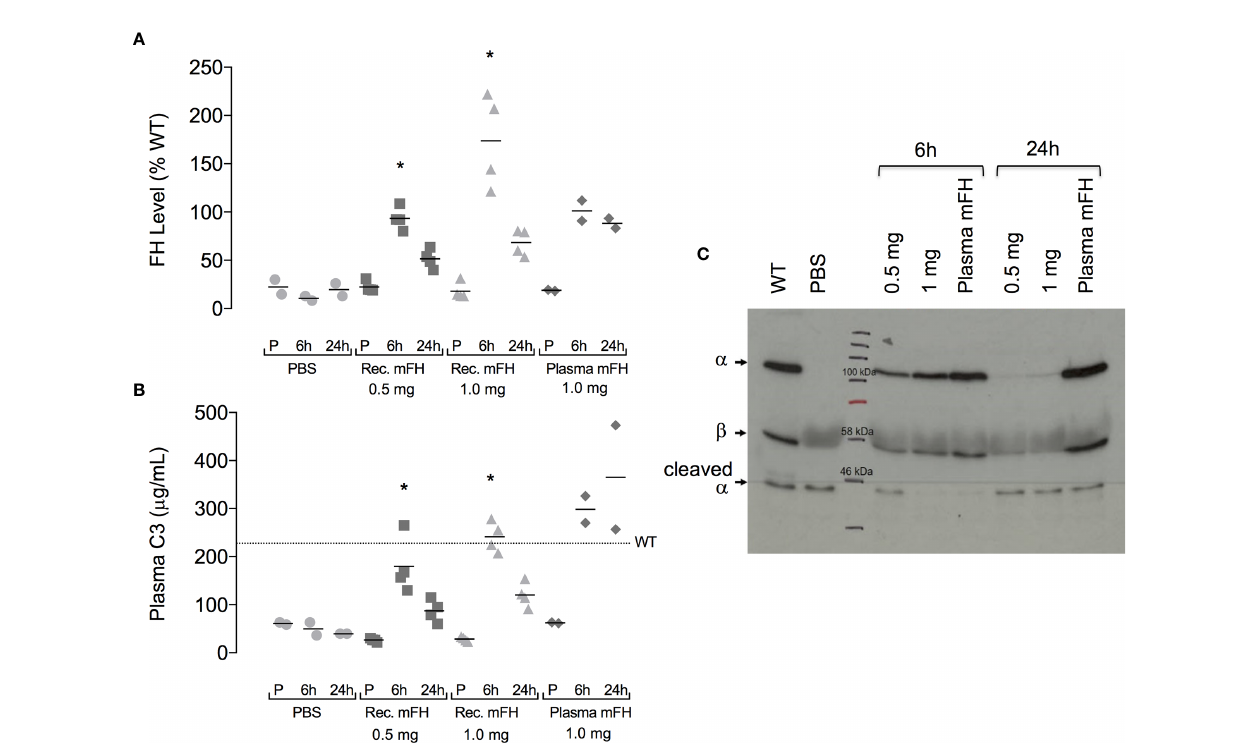
FIGURE 4 | Plasma complement pro fi le in CFH -/- mice after injection of mFH. (A) Plasma FH levels, and (B) plasma C3 levels, pre-injection (P) and six hours and 24 hours after IP injection of recombinant mFH (rec. mFH), FH puri fi ed from mouse serum (plasma mFH), or vehicle (PBS). Mean wild-type (WT) plasma C3 concentration (dotted line) = 230 µg/mL. Horizontal bars denote mean values. *P=0.0034 versus pre-injection value, Dunn ’ s Multiple Comparisons. (C) Western blot (reducing conditions) showing non-cleaved C3 a -chain after mFH